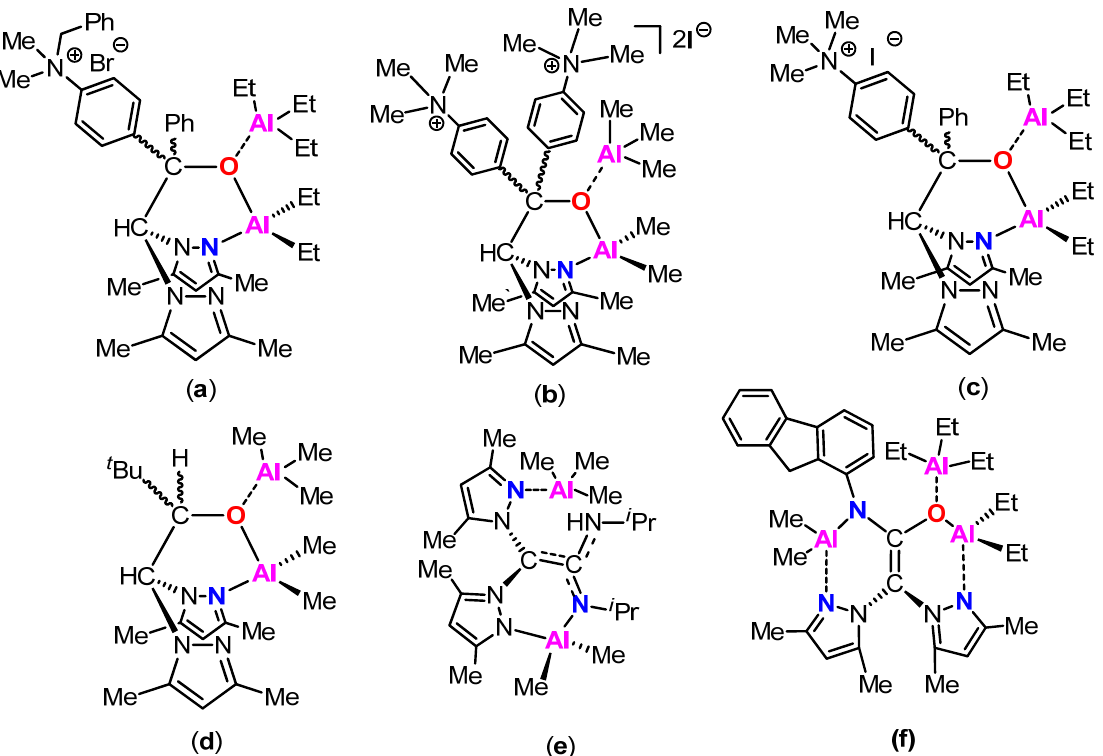
Figure 1. Aluminum adducts catalysts supported by scorpionate ligands: ( a ) [23]; ( b ) [60]; ( c ) [61]; ( d ) [62]; ( e ) [63]; ( f ) [64].